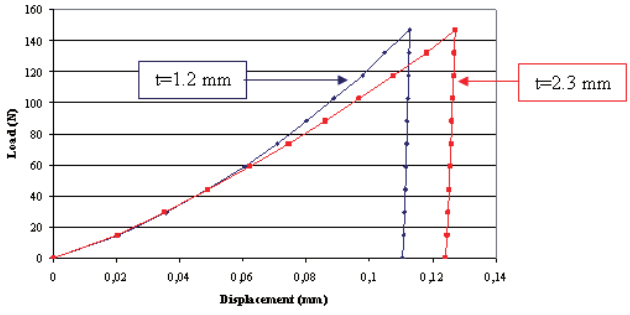
Fig. 9. Numerical load-indentation depth curves.